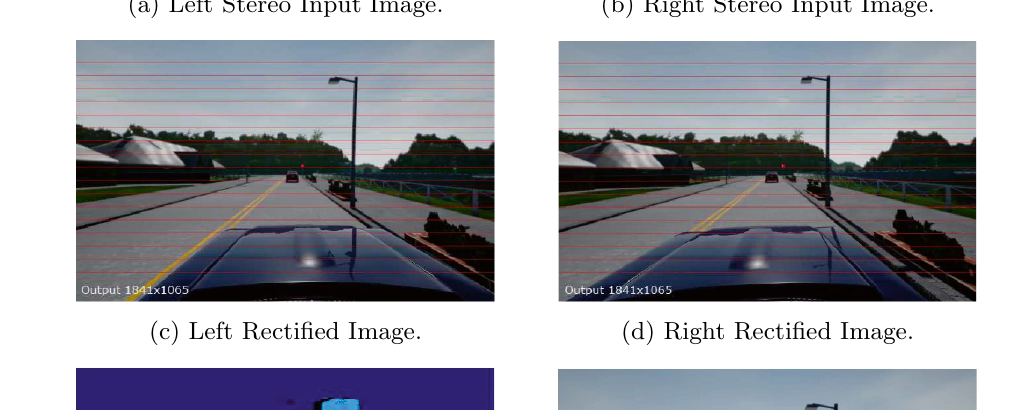
(c) Left Rectified Image. (d) Right Rectified Image.